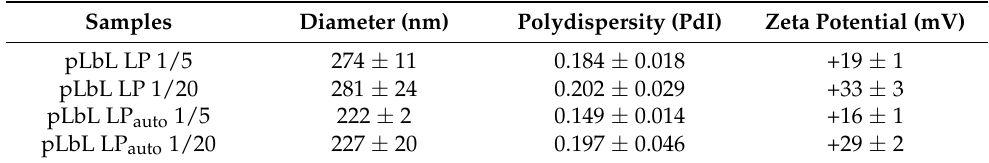
Table 4. Physicochemical characterization of pLbL formulations with either LP or LP auto as carriers through DLS and zetametry measurements. The formulations were prepared with Fluc mRNA, and the ratio of mRNA/LAH4-L1 was set at 1/20 or 1/5 w / w . Results are presented as the mean ± SD of samples ( n =